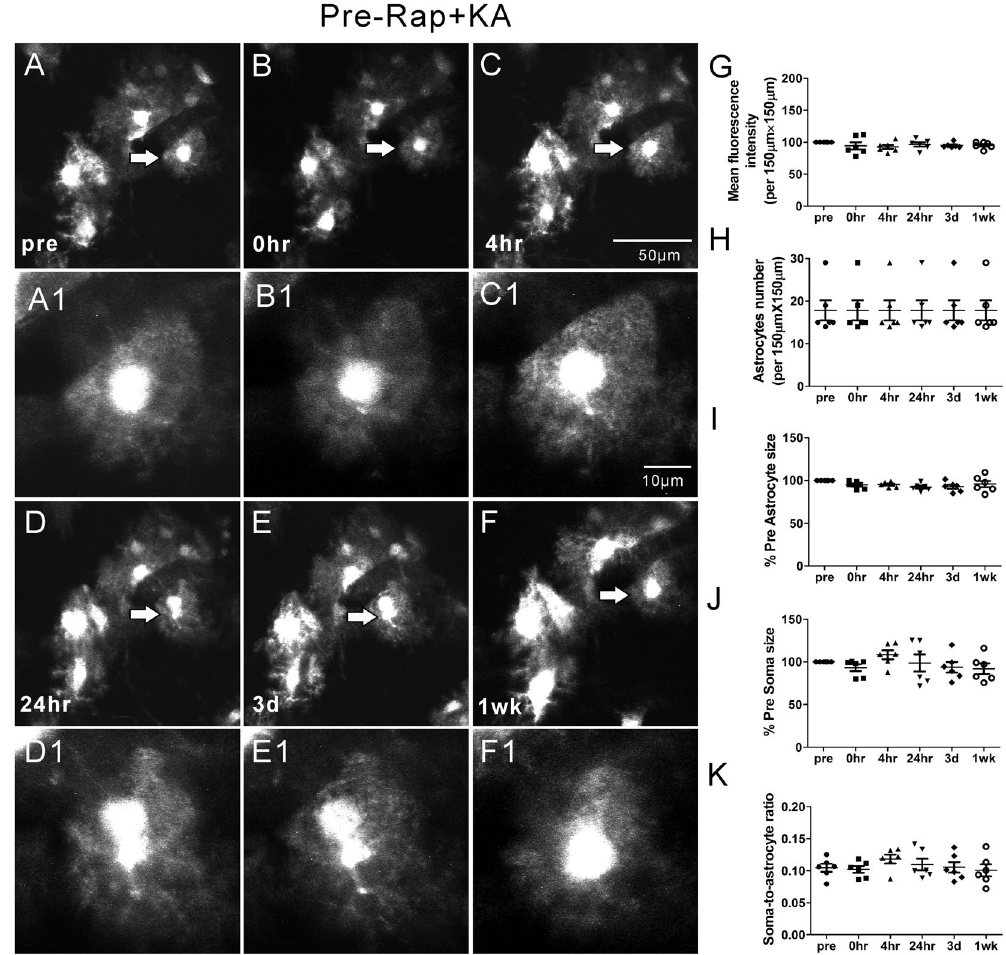
Figure 5. Representative in vivo images of astrocytes and quantitative analysis of astrocyte morphology features in the Pre-Rap + KA group. With rapamycin pre-treatment, the astrocytes reserved the normal bushy appearance after KA induced seizures. No obvious morphological change, vacuolization and astrogliosis were observed in most astrocytes ( A–F , A1–F1). The mean fluorescence intensity, astrocyte number, astrocyte size, soma size and soma-to-astrocyte ratio did not change over a one-week period ( G–K ) (n = 6; one-way ANOVA or Kruskal-Wallis test with Dunns post-test, p > 0.05). The arrows in the lower magnification images indicate the astrocytes displayed in the higher magnification